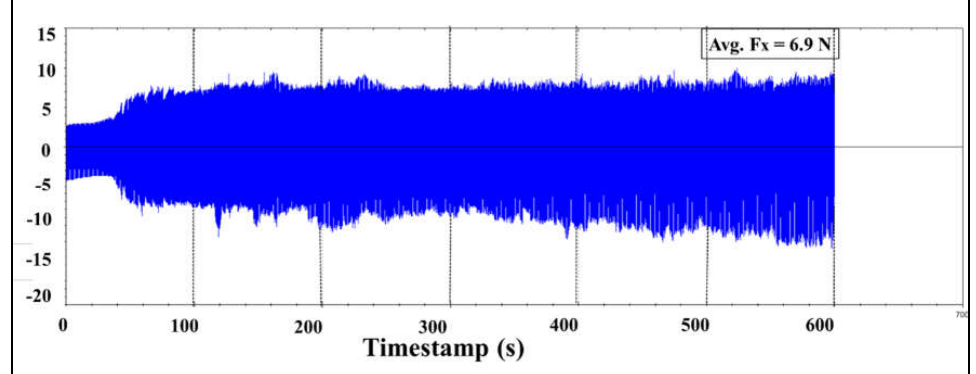
Figure 10. Generation of the friction force (F x ) graph for Al359/Si 3 N 4 /Eggshell surface composites. Figure 9 highlights the generation of the frictional force (F x ) value for the composite surface. At the beginning of the process, the generation of the frictional force value is low, but later on it increases and stabilizes (Figure 10). The average F x value for the composite surface is 6.9 N. Further, Figure 11 depicts the COF (µ) values for both the FSPed Al359 without reinforcement and Al359/Si 3 N 4 /Eggshell surface composite. During the test, the COF value for the surface composite steadily increased during the first 80 s, and then continued to rise until approximately 170 s, where it reached roughly 0.42 µ. Afterwards,